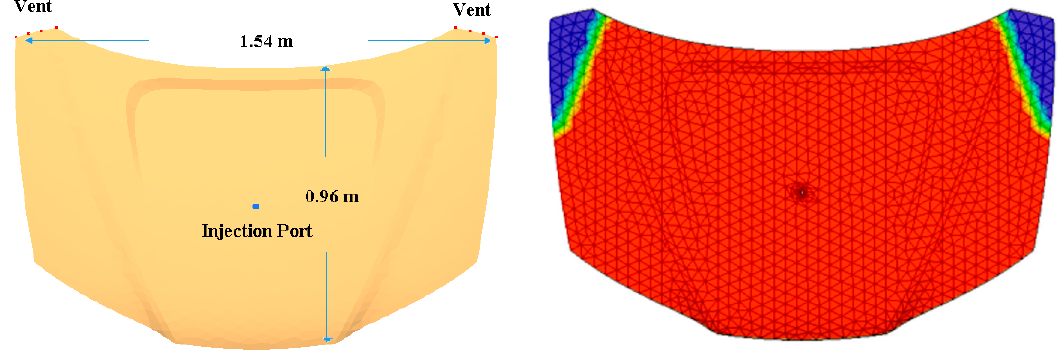
Figure 9. Second geometry ( left ) and injection simulation ( right ) of composite vehicle hood.